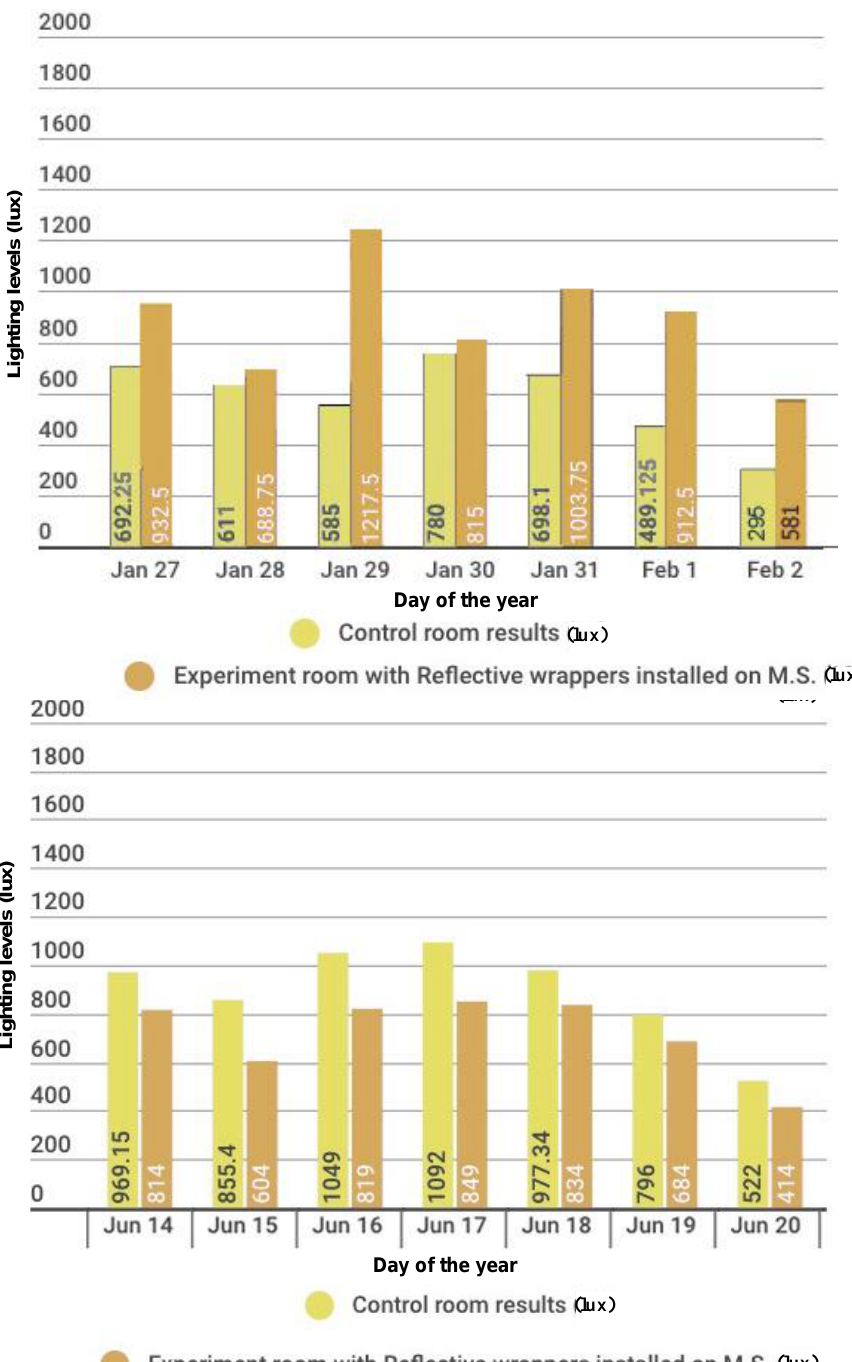
Figure 13. The figure represents the lighting outcomes in both the control room and experiment rooms in both the winter and summer after the installation of the reflective